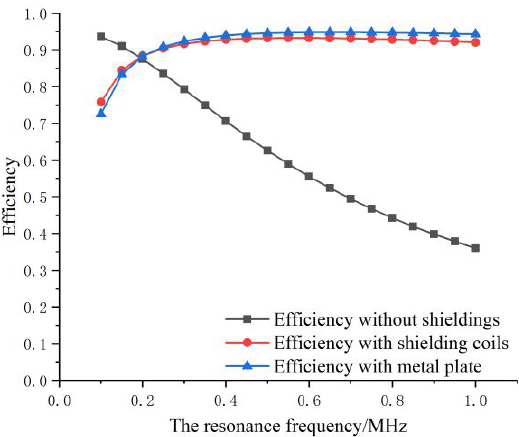
Figure 8. The power transmission efficiency changes with the resonance frequency.